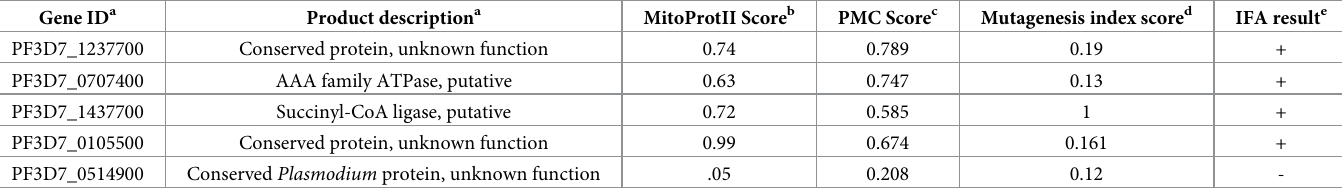
Table 1. Candidate proteins selected for localization